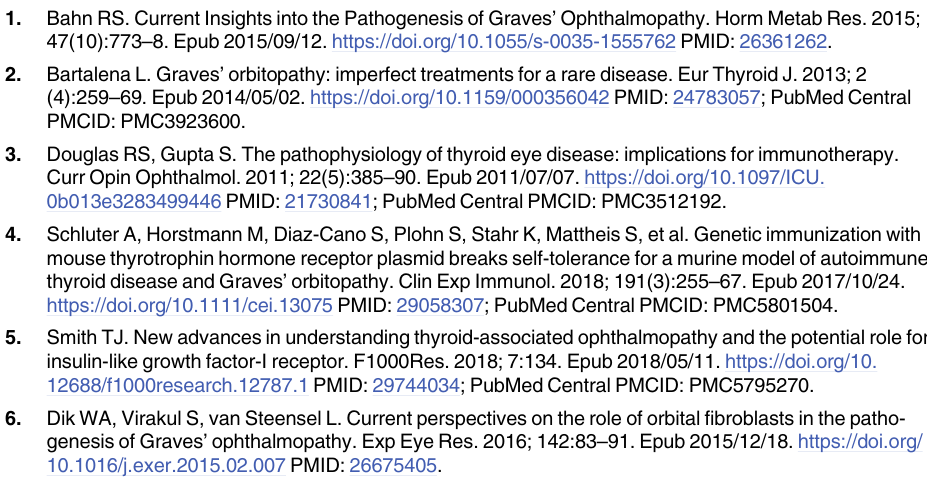
S1 Fig. Raw images of western blots preseneted in this manuscript. See the supplemental